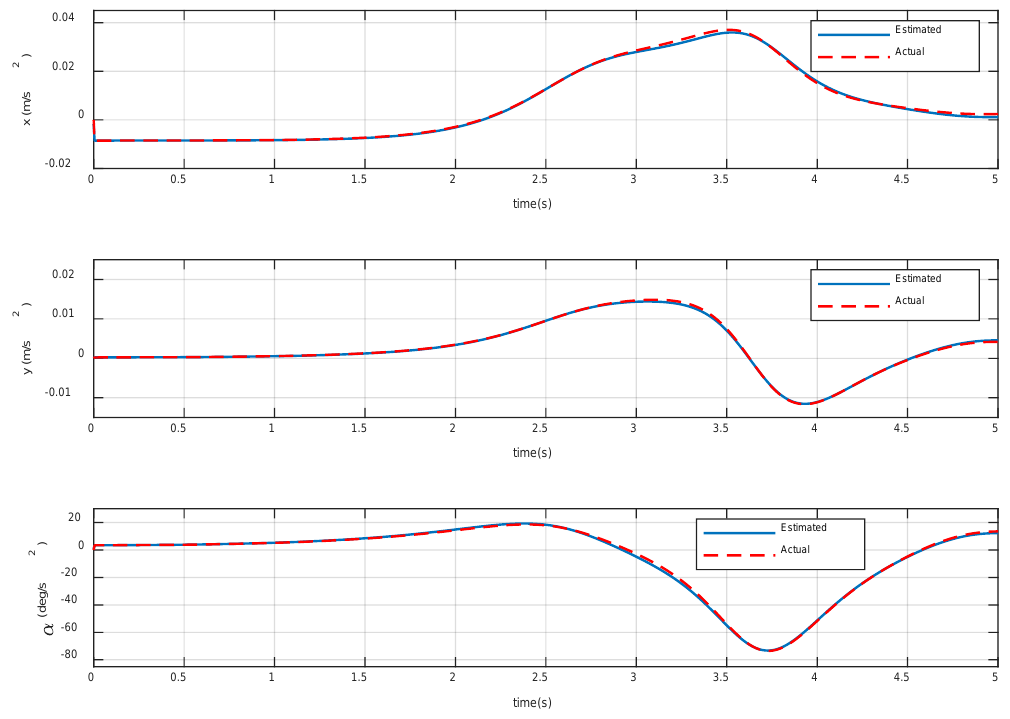
Figure 6. Variation of base acceleration and angular acceleration.